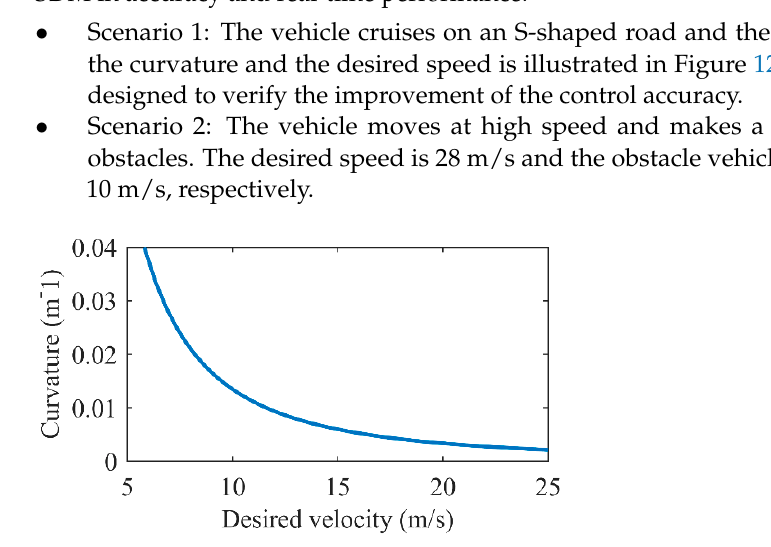
Figure 12. Relationship between curvature and desired speed.